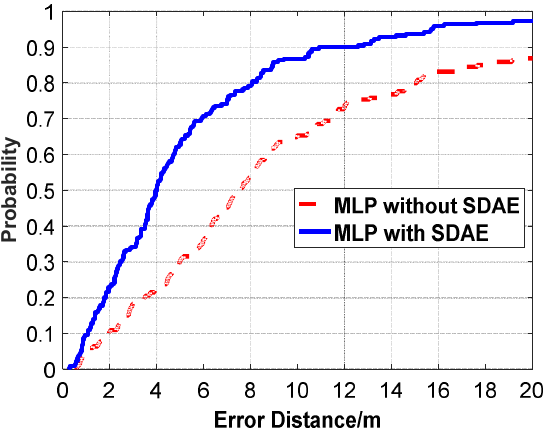
Figure 12. Comparison of CDF (Cumulative Distribution Function) positioning errors between the algorithm with feature extraction and the algorithm without feature extraction.